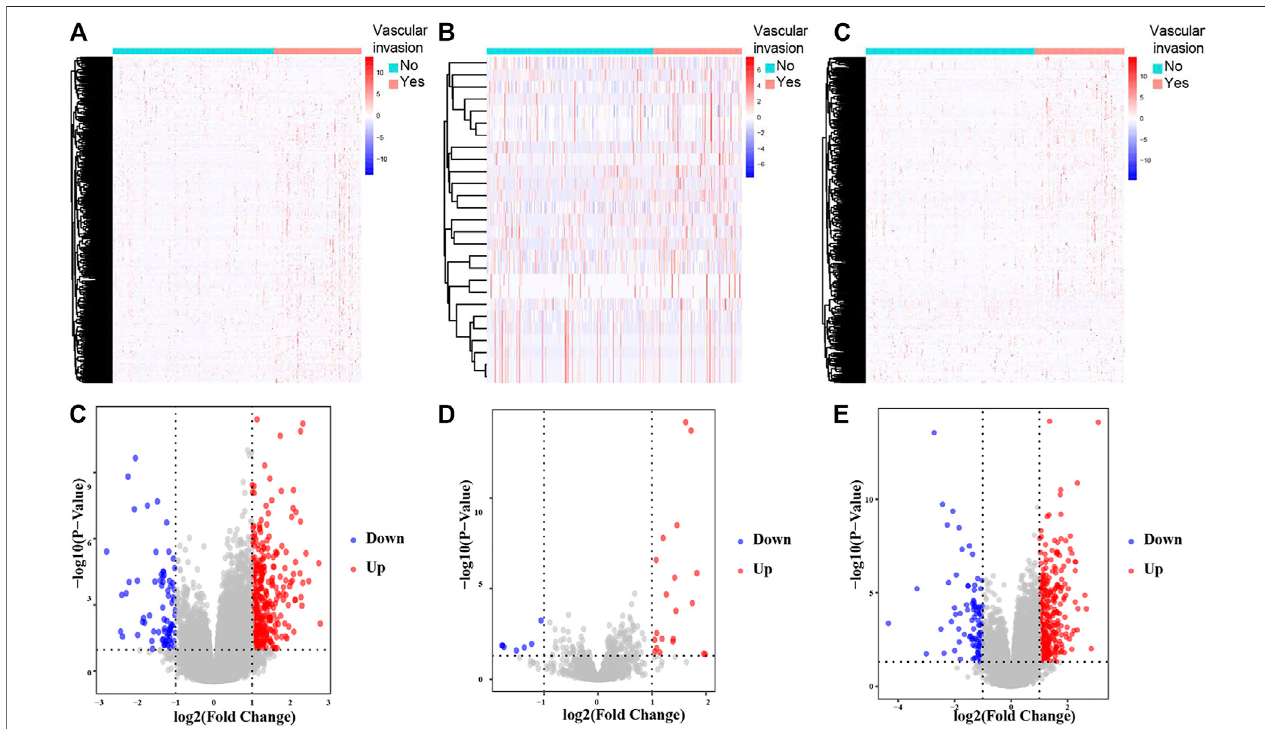
FIGURE 2 | Hierarchical clustering heatmaps and volcano plots for all screened DElncRNAs, DEmiRNAs and DEmRNAs based on TCGA-LIHC data. Heatmaps locatedintheleftpanelsrepresentDElncRNAs (A) ,DEmiRNAs (B) ,andDEmRNAs (C) .Annotationsontopshowtheclusteringofthesamples.Greenrepresentsprimary HCC;redrepresentsHCCwithvascularinvasion.VolcanoplotslocatedintherightpanelsindicateDElncRNAs (D) ,DEmiRNAs (E) ,andDEmRNAs (F) withcutoffcriteria of p < 0.05 and |FC| ≥ 1. Red, upregulated; blue,